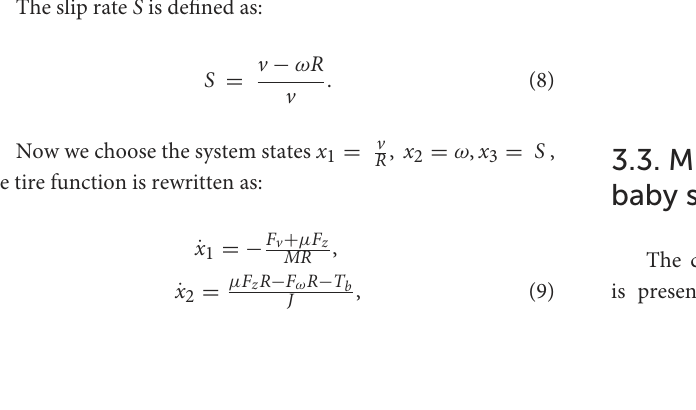
The control diagram based on MPC for the baby stroller is presented in Figure 7C. Basically, the MPC algorithm